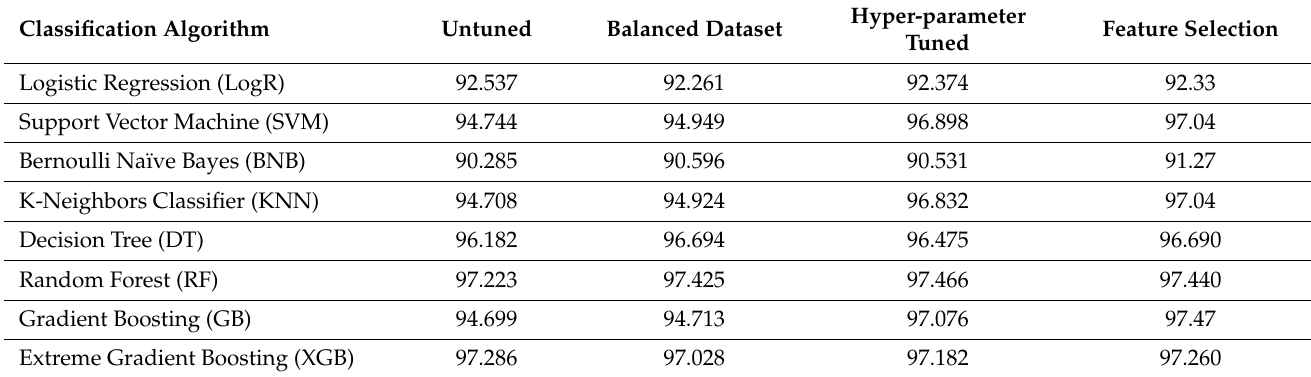
Table 16. Dataset-1 performance (accuracy %) comparison.